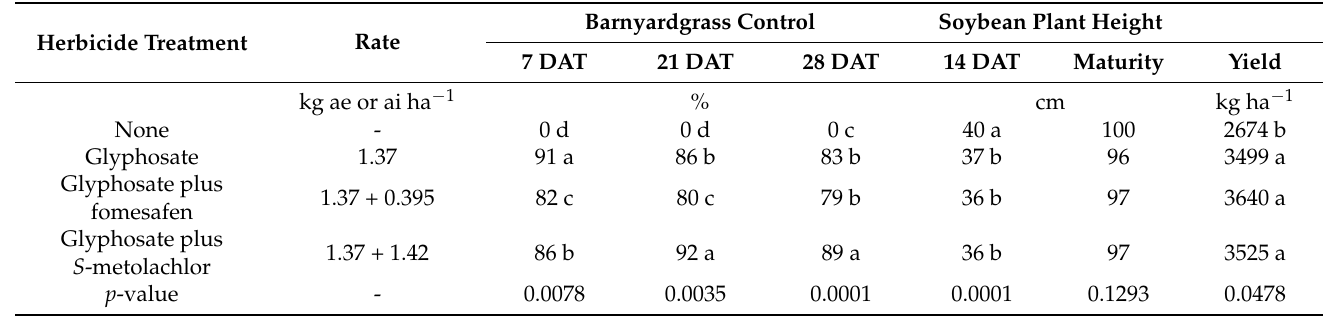
Table 4. Barnyardgrass control 7, 21 and 28 d after treatment (DAT), soybean plant height 14 DAT, mature plant height, and yield that resulted from soybean receiving tank mixtures of POST herbicide treatments and cytokinins applied at the V3 growth stage in Stoneville, MS, during 2015 and 2016 † . Barnyardgrass